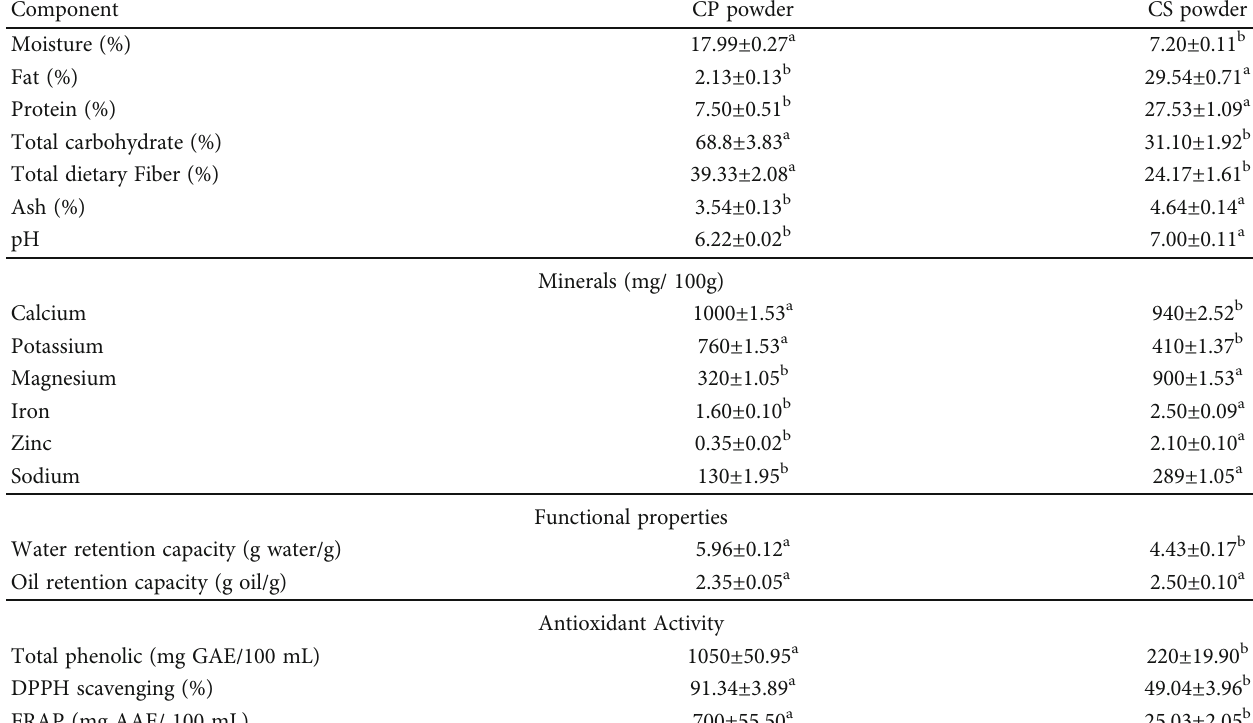
Table 2: Physiochemical analysis, mineral content, functional properties, and antioxidant activity of cantaloupe peel (CP) and seed (CS)